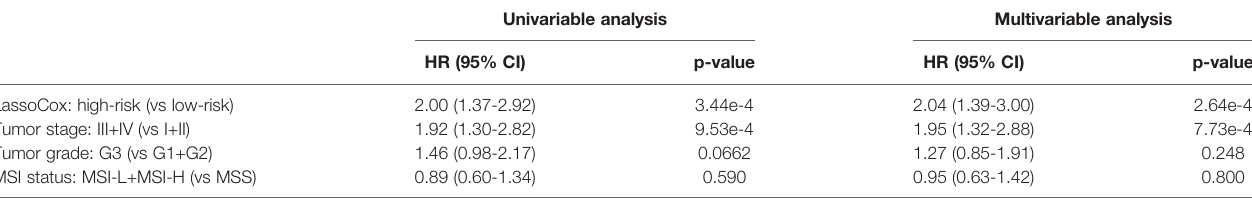
TABLE 2 | Univariable and multivariable Cox proportional hazards model analysis of the prognostic value of lassoCox and three clinical